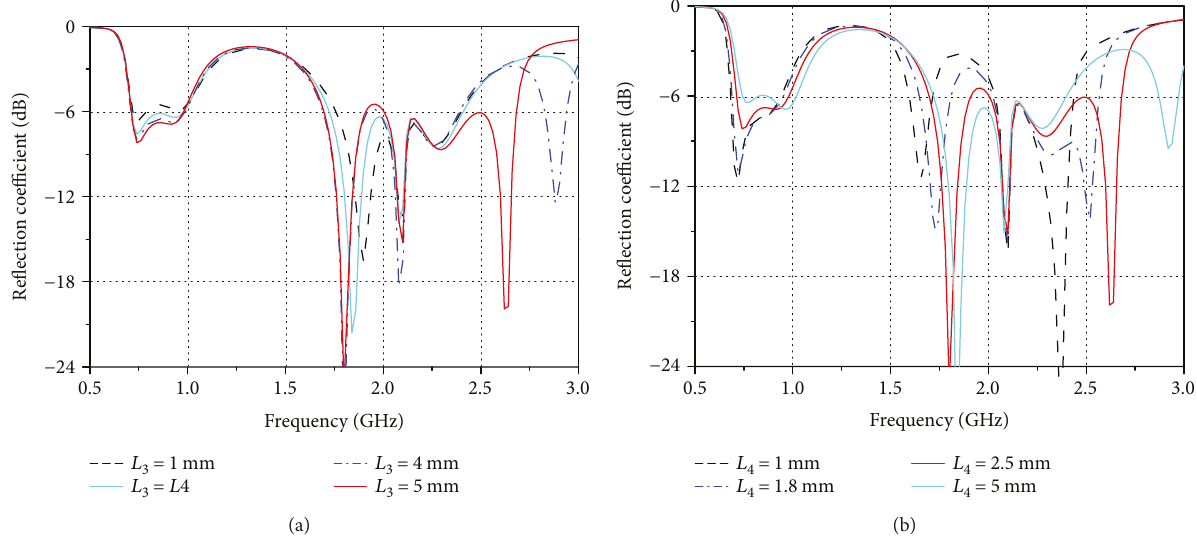
Figure 6: Simulated re fl ection coe ffi cient for the proposed antenna as a function of (a) L L is kept 3